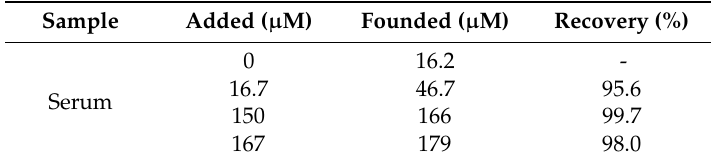
Table 2. Analytical results of Cys in FBS serum sample.